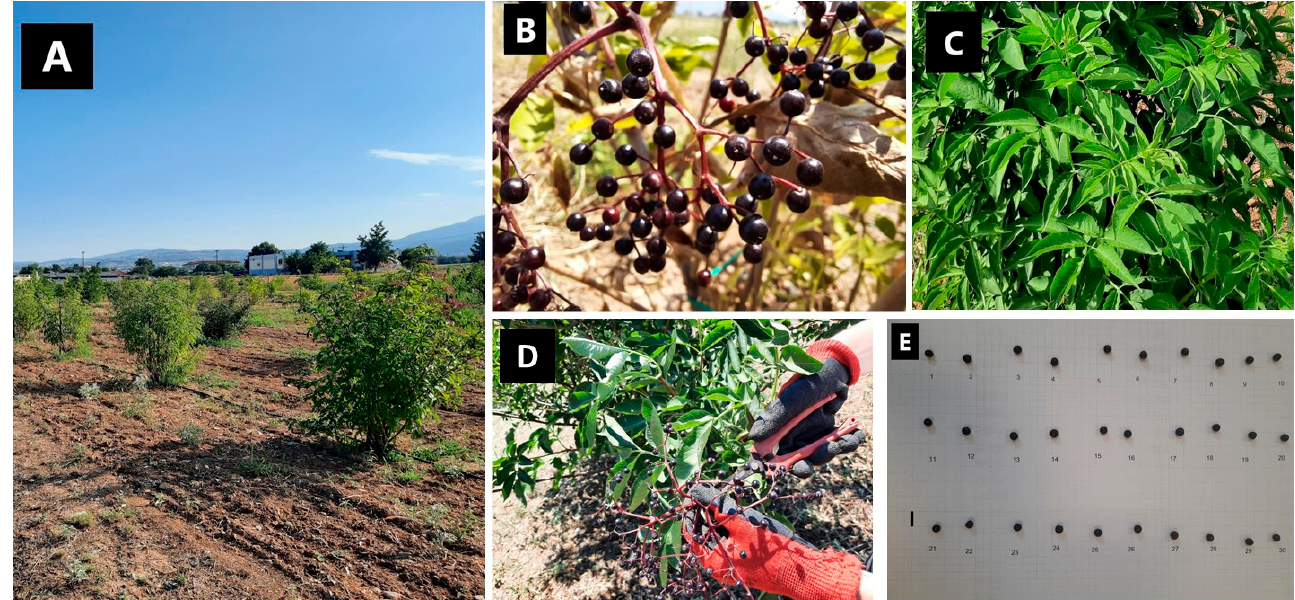
Figure 2. Representative photos of the materials used for phytochemical and physicochemical analyses from cultivated germplasm of Sambucus nigra genotype GR-1-BBGK-19,73. ( A ) Two-year-old S. nigra plants established at the cultivation trial; ( B ) ripe S. nigra fruit clusters; ( C ) composite leaves taken for analysis; ( D ) collection of fruits; and ( E ) fruit examination before analysis (inside bar indicates 1 cm).